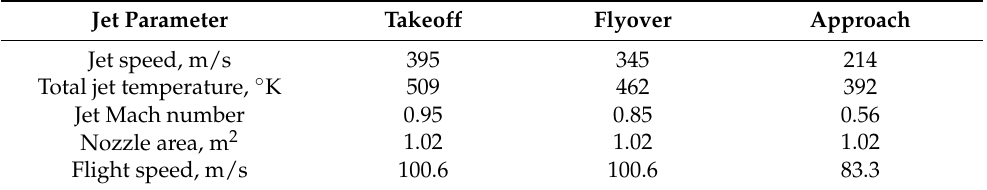
Table 3. Jet parameters for the next-generation aircraft concept during departure and approach.